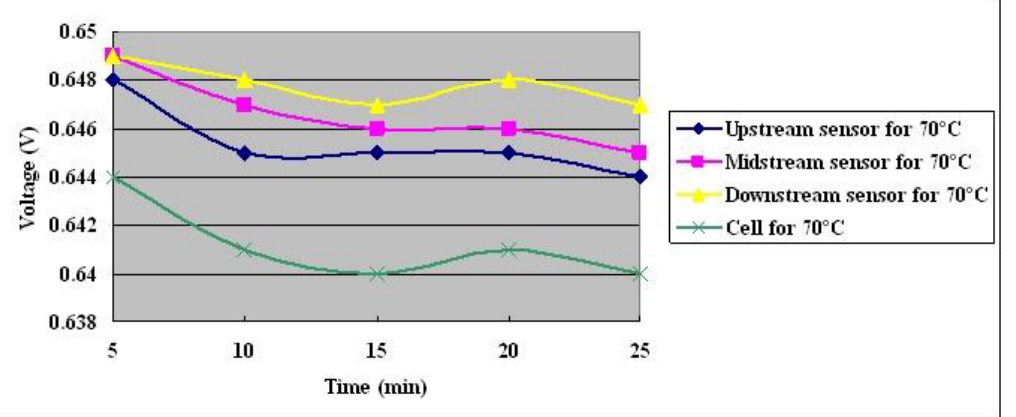
Figure 16. Voltage distributions at cell temperature of 70  C with constant output current of 25